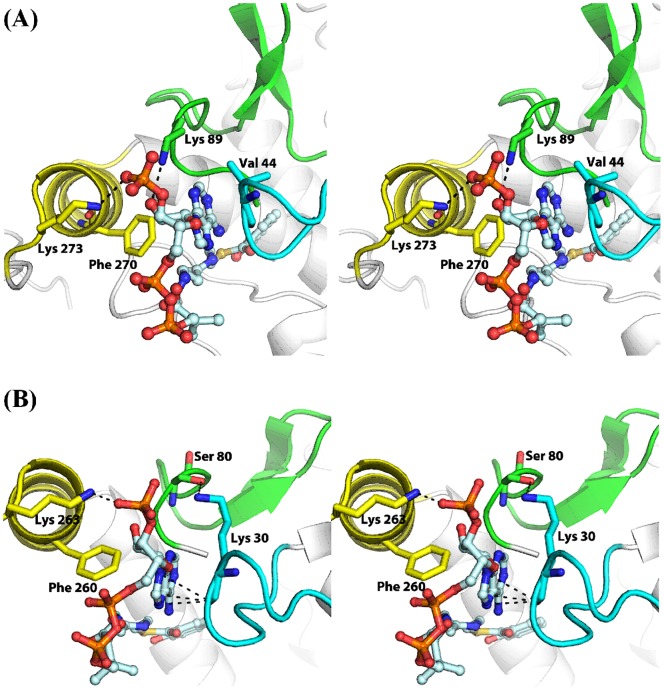
New interactions between the coenzyme A thioesters and the ligand-induced loop-helix assembly in the ecMenB:HNA-CoA (A) and scMenB:SA-CoA (B) complexes.The ordered A-loop is colored green and the C-helix is colored yellow. The loop connecting the second β-sheet and the first α-helix at the N-terminus, called loop 2, is colored blue. The ligands are represented as sticks with C, O, N, S and P atoms colored light blue, red, blue, brown and orange, respectively. Amino acid residues involved in interaction with the ligands are in stick representation with carbon atoms in the same color as the substructures. Dashed lines represent distances less than 3.5 Å.